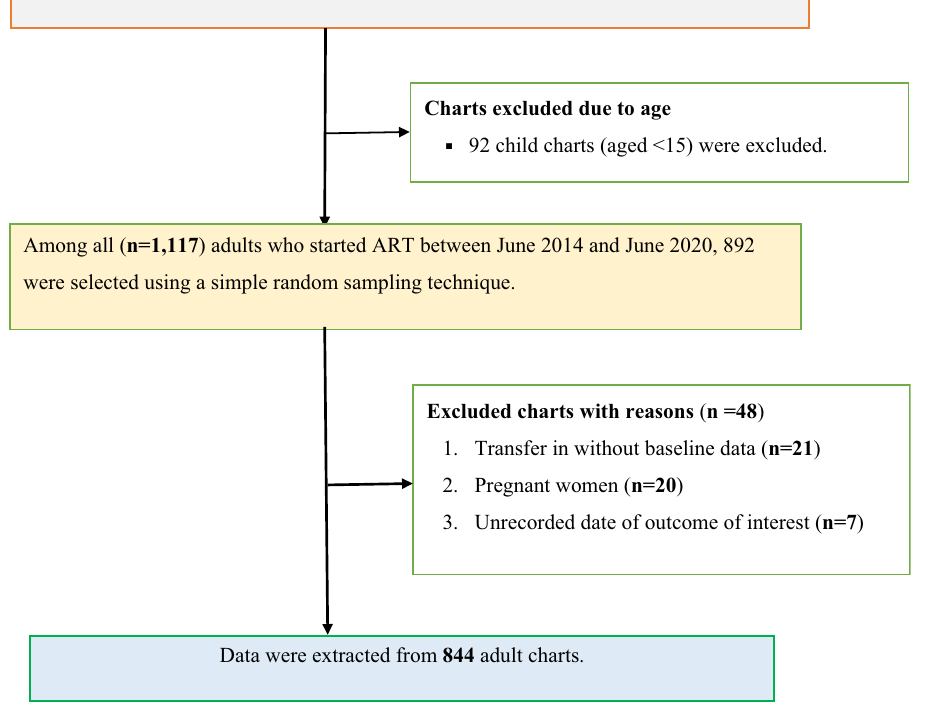
Figure 1. Study participants’ recruitment process at Debre Markos Comprehensive Specialized Hospital in Northwest Ethiopia, between June 2014 and June